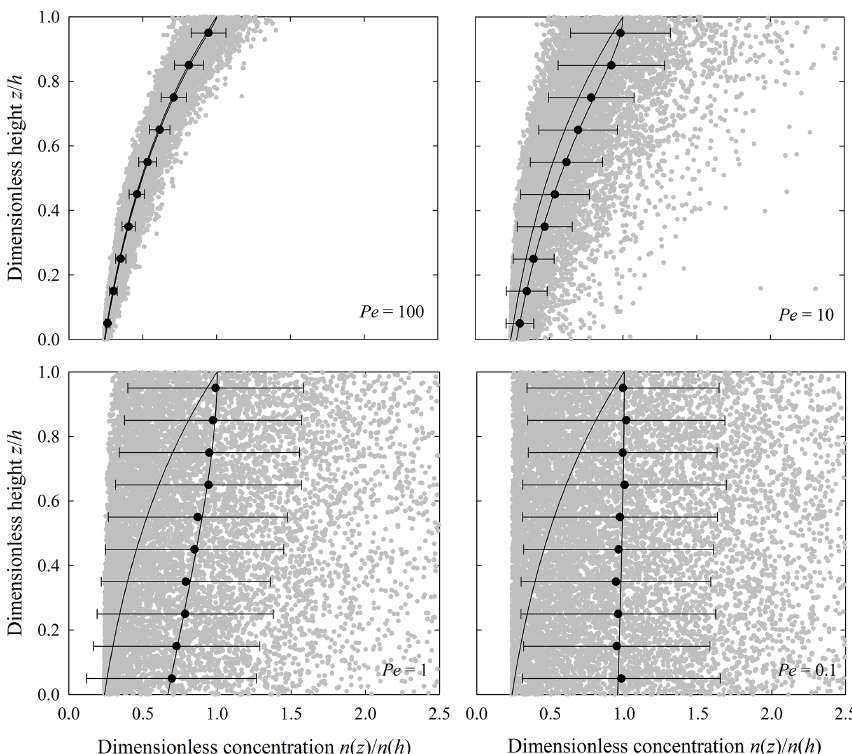
Figure 3. Plot of dimensionless 10 Be concentration ˆ n = n ( z ) /n ( h ) versus dimensionless height ˆ z = z/h showing simulated particle concen- trations ˆ n p (gray dots) for Pe = 100, 10, 1, 0.1, and estimates of expected concentrations ˆ n averaged within 0 . 1 h intervals (black circles) with one standard deviation bars. Simulations represent uniform mixing with κ z = K z . Right solid line is the theoretical result, and left solid line represents the absence of